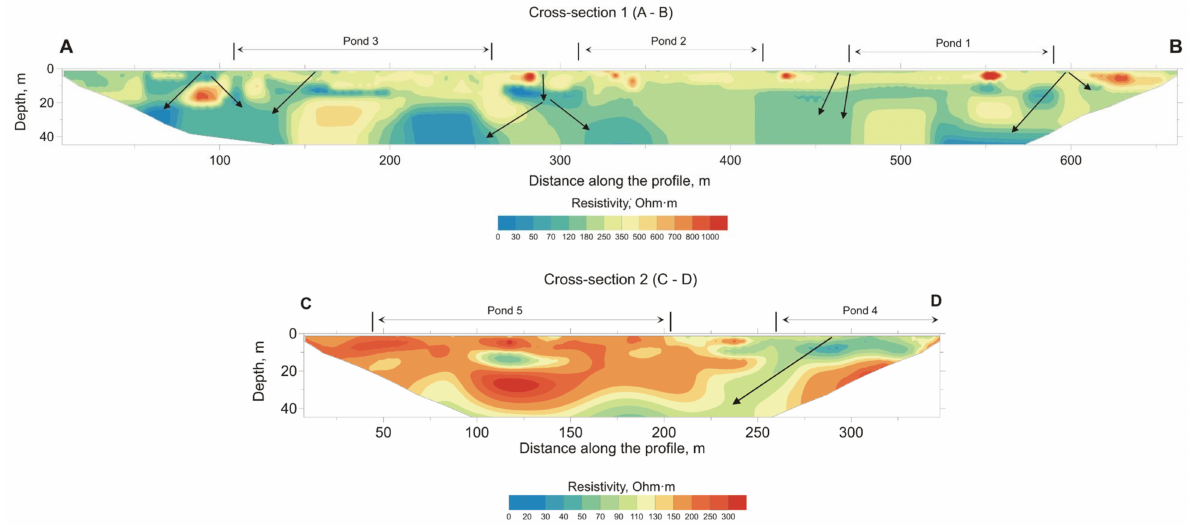
Figure 2. Geoelectrical zonality of subsurface space along profiles 1 and